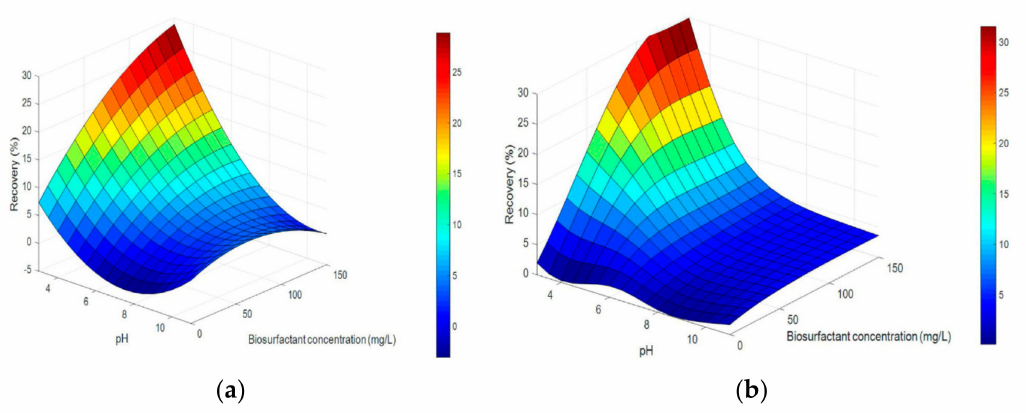
Figure 10. ( a ) Quartz recovery using a second-order polynomial as a prediction model ( R 2 = 0.931), ( b ) quartz recovery using an artificial neural network as a prediction model ( R 2 = 0.982)